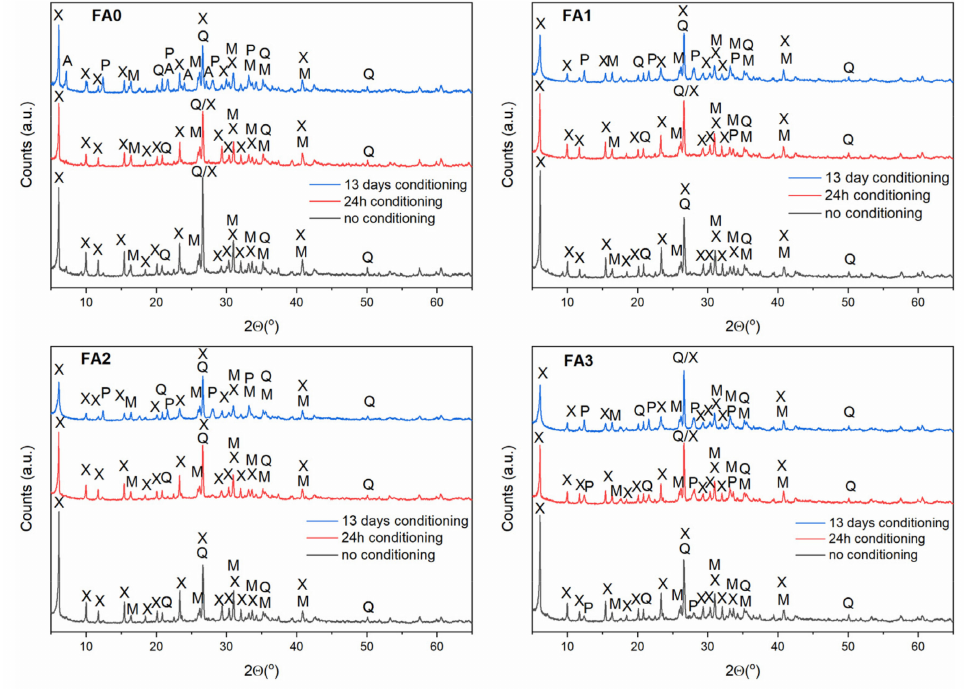
Figure 9. The effect of FA milling and solution conditioning on the FA conversion into Na-X zeolite phase. Clarifications: X—zeolite Na-X, M—mullite, Q—quartz,